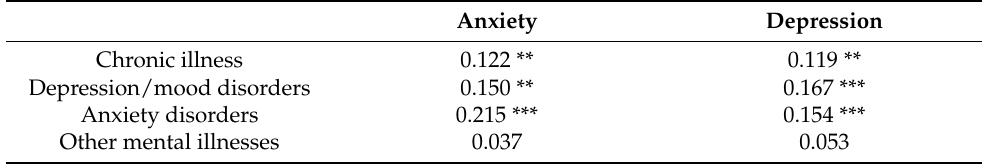
Table 3. Correlations between HADS scores and health problems.